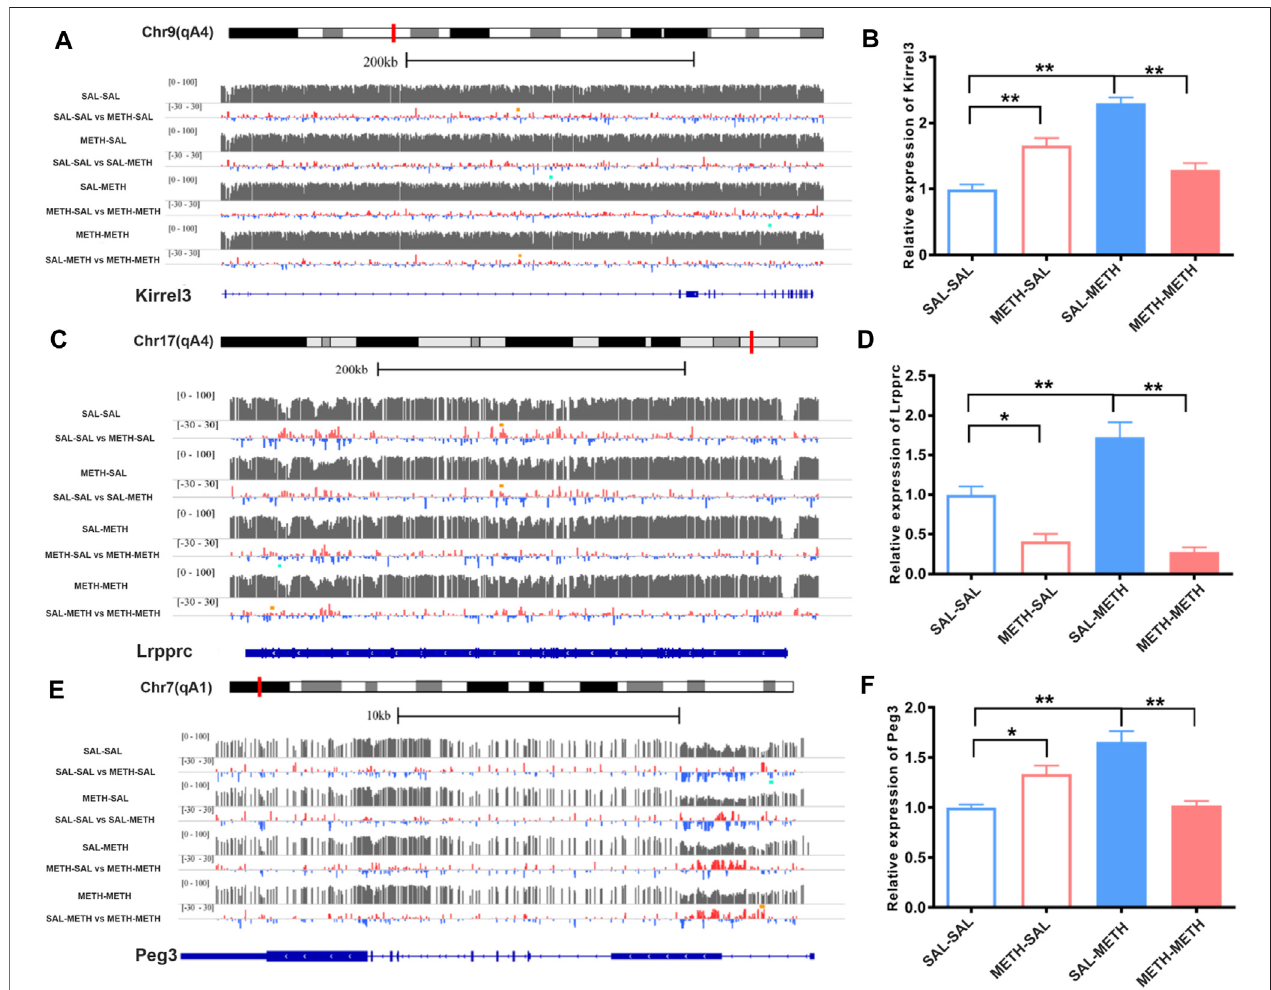
FIGURE 6 | Illustration of DNA methylation changes of Kirrel3, Lrpprc, and Peg3 genes in NAc of prenatal or postnatal METH-exposed males. Left panel (A,C,E) showsexpandedviewsofDNAmethylationpatternsforsamplegeneloci,visualizedusingtheUCSCgenomebrowser:Kirrel3;Lrpprc;andPeg3.Foreachgene,tracks 1,3,5,and7showtheaveragemethylationintensityofthesalinegroup,prenatalMETHgroup(METH-SAL),postnatalMETHgroup(SAL-METH),andpre-andpostnatal METH group (METH- METH) respectively. Tracks 2, 4, 6, and 8 show average methylation differences between the two experimental conditions. Green dots represent regions signi fi cantly hypo-methylated corresponding to the correspondence control track. Orange dots represent regions signi fi cantly hyper-methylated corresponding to the correspondence control track. DMRs were considered differentially methylated if their FDR was at most 0.05. The last track shows exons and intronsbasedonthemouseNCBIRNAreferencesequencescollection(RefSeq).Rightpanel (B,D,F) showschangesinexpressionofKirrel3,Lrpprc,andPeg3genesin NAc of prenatal or postnatal METH -exposed males. one-way ANOVA followed by a Bonferroni post hoc test was used. * p < 0.05,** p < 0.01 compared with the corresponding control mice, respectively. SAL-SAL, pre- and postnatal SAL exposure; METH-SAL, prenatal METH and postnatal SAL exposure; SAL-METH, prenatal SAL, and postnatal METH exposure; METH-METH, pre- and postnatal METH exposure. Data in each group are based on n = 3. qPCR data are presented as Mean ± SEM.